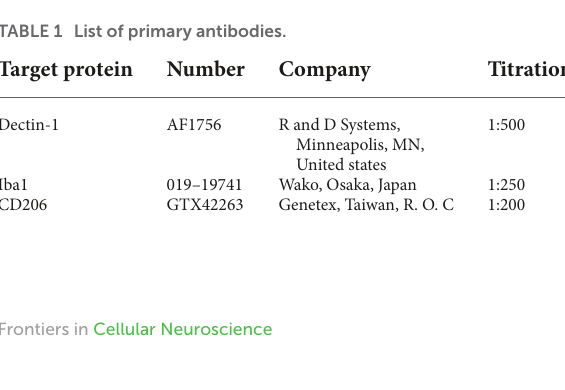
for another 2 h, then stored in 0.1 M phosphate buffer